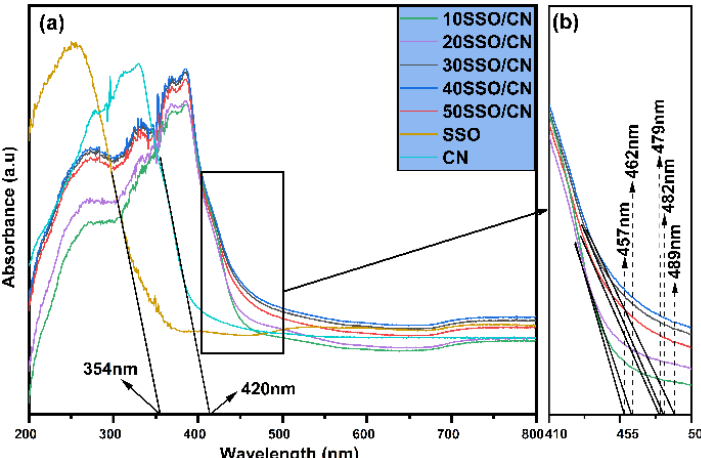
Figure 5. The UV-Vis patterns of CN, SSO, 10SSO/CN, 20SSO/CN, 30SSO/CN, 40SSO/CN, 50SSO/CN ( a ); the high-resolution patterns ( b ).